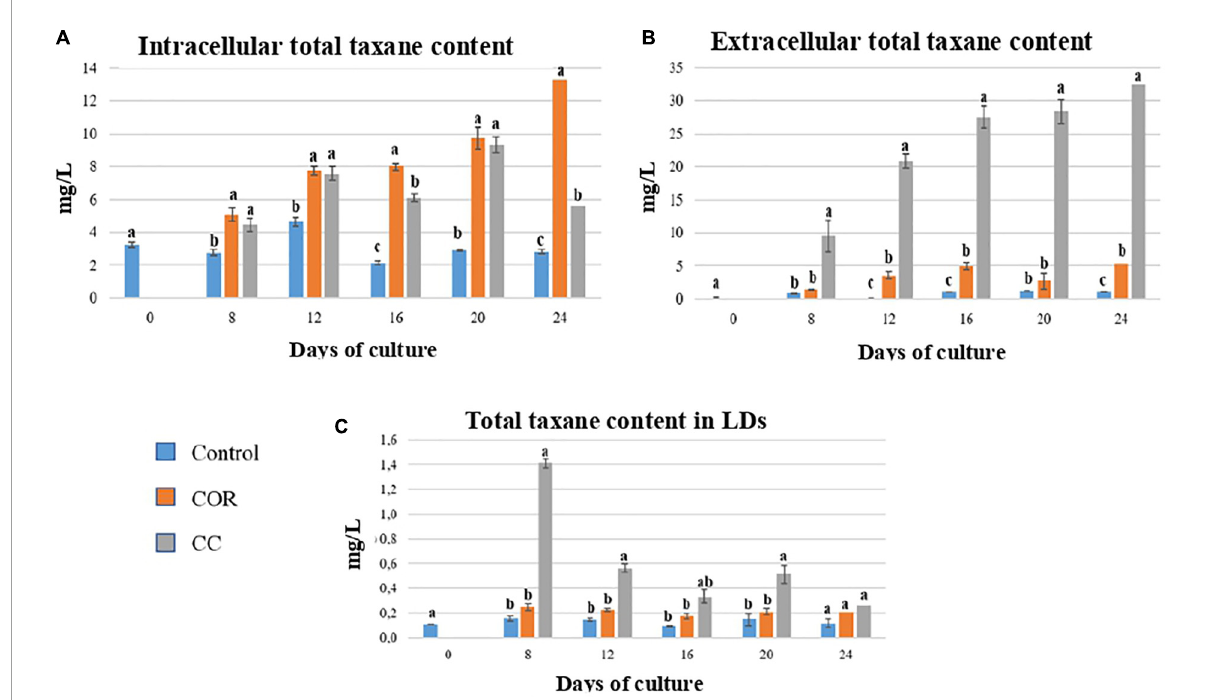
FIGURE4 Total taxane contents found throughout the experiment inside the cells (A) , liquid medium (B) and lipidic droplets (LDs) (C) in T. baccata cell cultures in control conditions and with the addition of 1 mM coronatine (COR) or 1 mM COR plus 50 mM β -cyclodextrins (CC). Values presented are means ± SD ( n = 3). Values followed by different letters are significantly different ( P ≤ 0.05) according to Tukey’s honestly significant difference test.